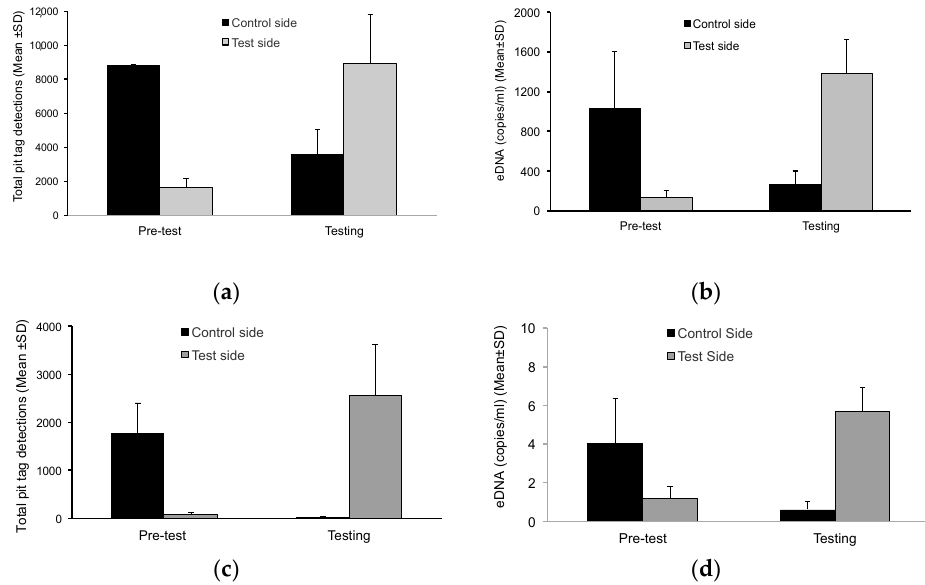
Figure 1. ( a ) Total number of detections (Mean ± SD) of silver carp at the test and control sides during pre-test (with no spirulina addition at the test side of the pond) and test periods (during spirulina addition to the test side of the pond) of experiment 1. Values for experiment 1 are all three ponds combined. ( b ) eDNA concentrations (Mean ± SD) at the control and test sides during the pre-test and testing periods of experiment 1. Mean eDNA copy numbers for each side and periods were only available, so the SD value is calculated for the technical replicates of the assay ( c ) Total number of detections (Mean ± SD) of common carp at the test and control sides during pre-test (with no PGF2 α addition at test side of the pond) and testing periods (during PGF2 α addition to the test side of the pond) experiment 2. ( d ) eDNA concentrations (Mean ± SD) at the control and test sides during the pre-test and testing periods of experiment